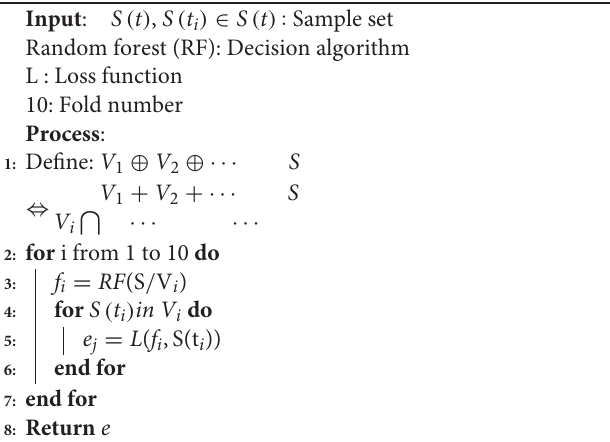
Algorithm 3: 10-Fold Cross-validation(S, RF, L,